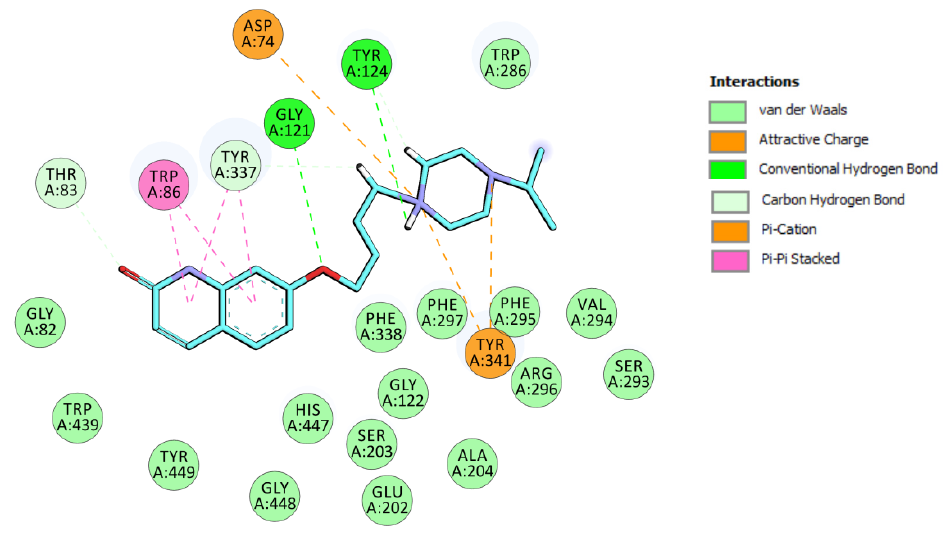
Figure 8. 2D schematic view of the interactions between QN8 and hr AChE.